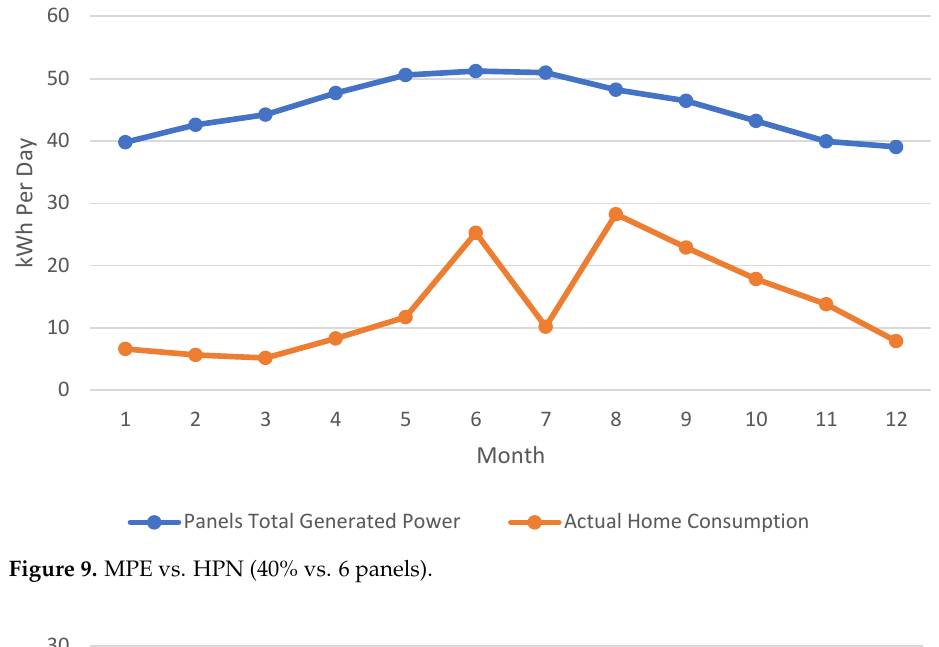
Figure 9. MPE vs. HPN (40% vs. 6 panels).